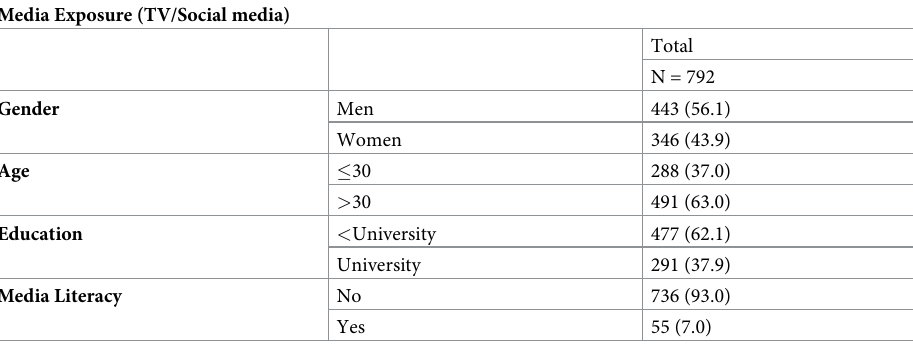
Table 1. Sample demographic